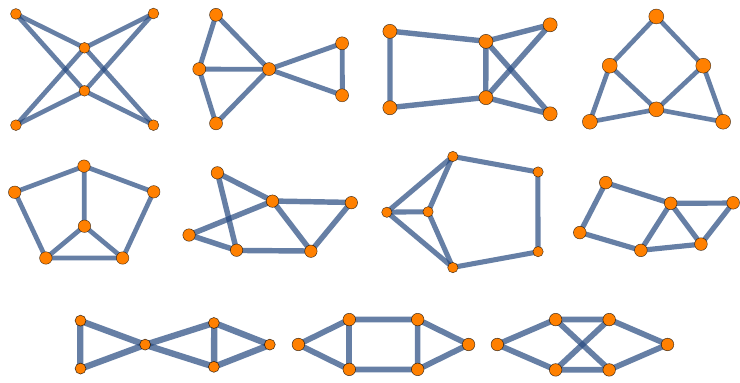
Figure 2 . The skeleton graphs at two loops generated by Sage. The (cid:12)nal set of ribbon graphs is obtained from these by adding the colour factors and summing over all inequivalent assignments of external and internal points to the